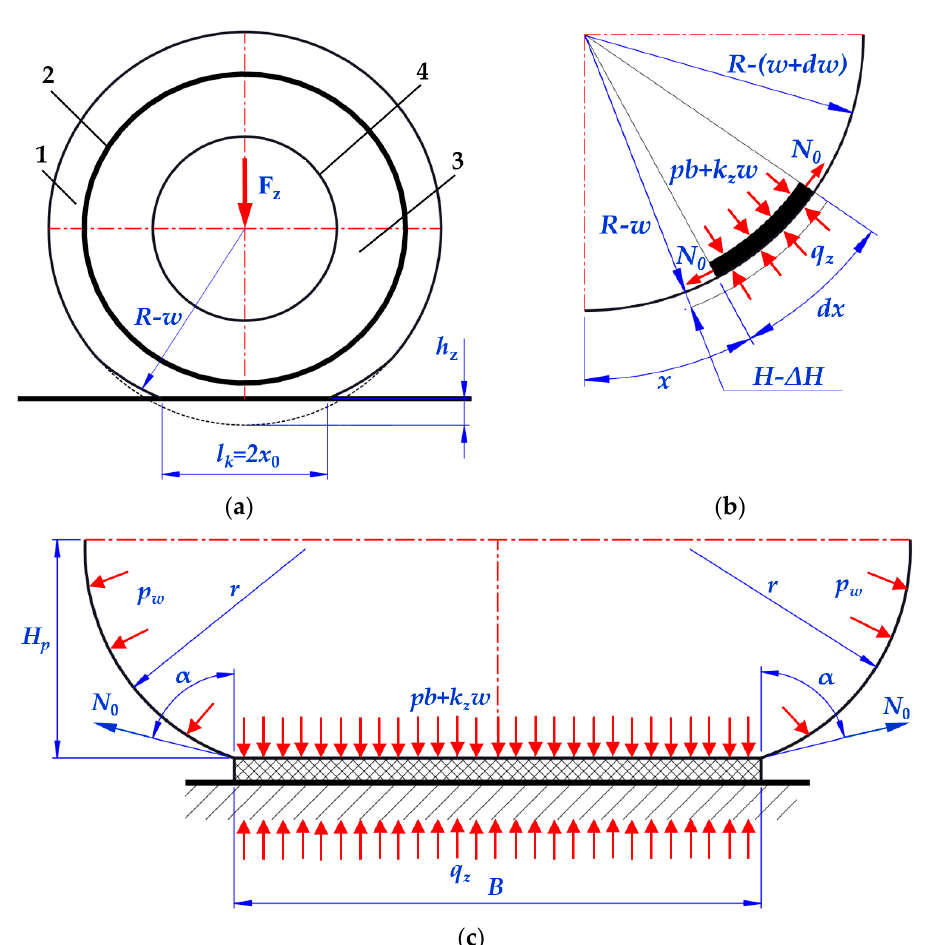
Figure 4. Model of the deformable ring of the tire: ( a ) deformable ring; ( b ) deformable ring element; ( c ) cross-section scheme for assessing the impact of the cord; 1—elastic layer (tread); 2—breaker layers; 3—elastic base (side walls); 4—disk.